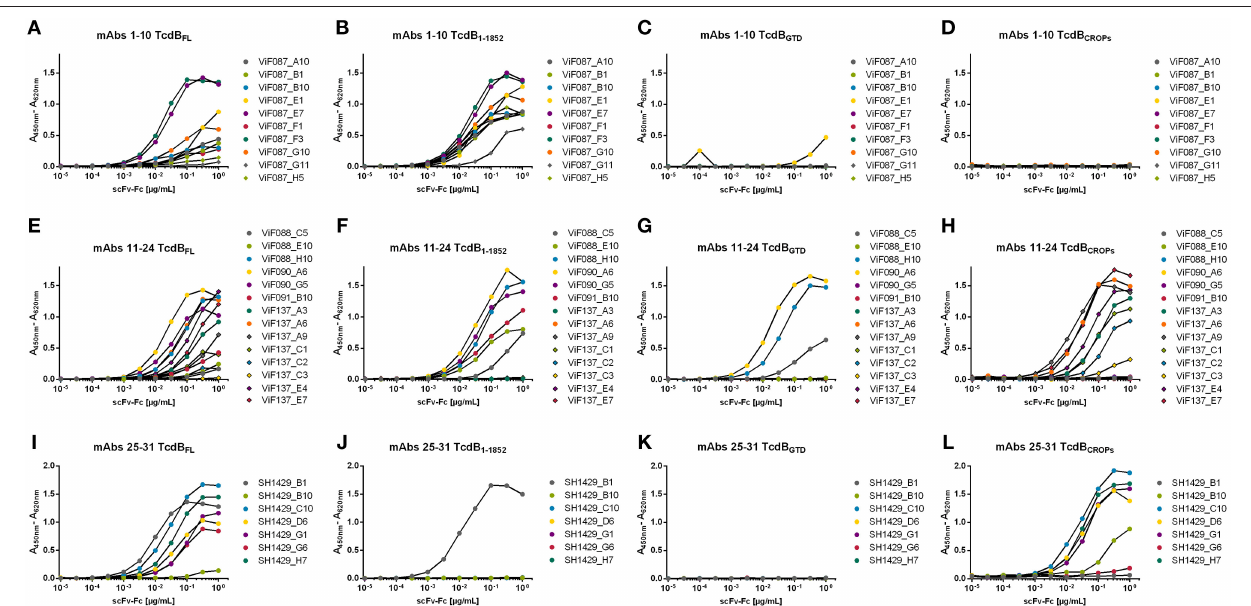
FIGURE 2 | Antigen ELISA on TcdB variants. 31 mAbs were tested for binding on 100 ng of immobilized fragments of TcdB or full length TcdB. Bound scFv-Fcs were detected using an HRP conjugated anti-human Fc γ antibody. (A,E,I) Titration on TcdB FL ; (B,F,J) Titration on TcdB 1 − 1852 ; (C,G,K) TcdB GTD was used as antigen; (D,H,L) Titration on TcdB CROPs